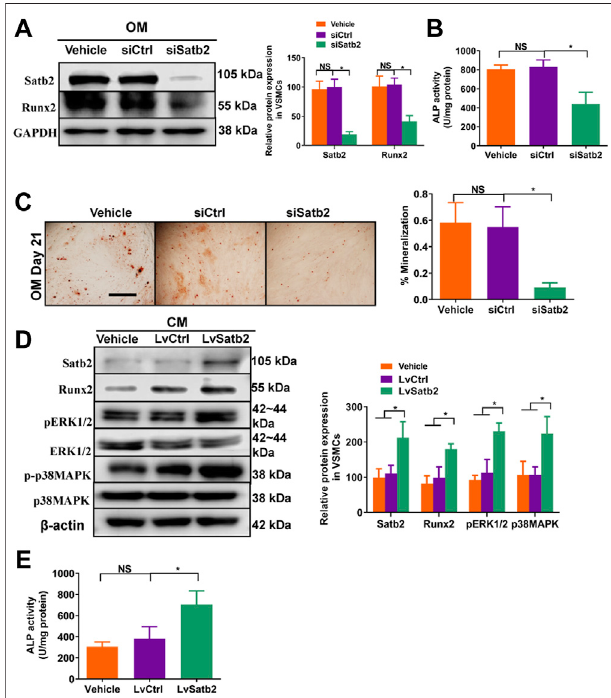
FIGURE 5 | Knockdown of Satb2 inhibits osteogenic differentiation of VSMCs. OM-treated VSMCs were transfected with control siRNA (siCtrl), Satb2 siRNA (siSatb2), or vehicle control for 48 h. (A) Western blotting was performed to evaluate Satb2 and Runx2 expression. The data were presented as densitometric ratios normalized to GAPDH [ (A) , right panel]. (B) The ALP activity was determined by an Elisa kit. (C) Alizarin Red S staining were measured in ß -GP-treated VSMCs infected with siCtrl or siSatb2 for 21 days. Representative microscopic views are shown. Scale bar represents 200 µm. Data were presented as ratio of positive staining area [ (C) , right panel]. CM-treated VSMCs were infected with control lentivirus (LvCtrl), Satb2-expressing lentivirus (LvSatb2), or vehicle control for 48 h. (D) Western blotting was performed to evaluate Satb2, Runx2, pERK1/2, ERK1/2, p38MAPK, and p38MAPK expression. The data were presented as densitometric ratios normalized to ß -actin or phosphorylation/total protein [ (D) , right panel]. (E) The ALP activity was determined by an Elisa kit. Each experiment was repeated for three times. The data represent the mean ± SD of triplicates. * p <